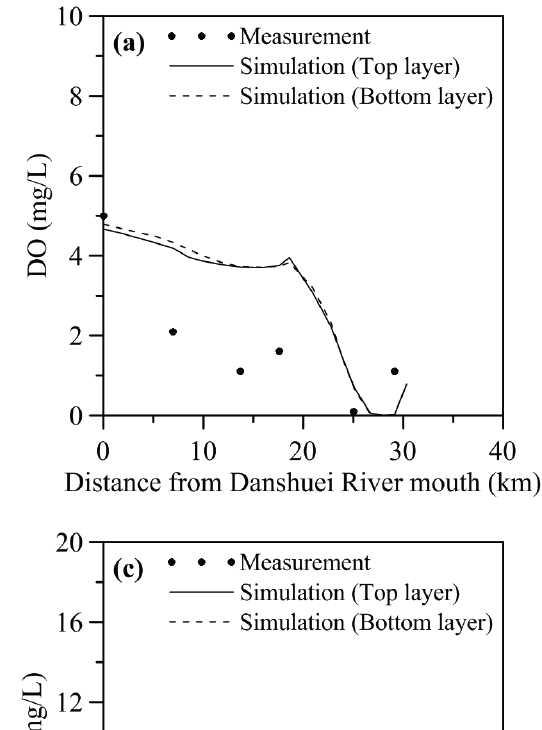
; ( d ) total phosphorus 4 3